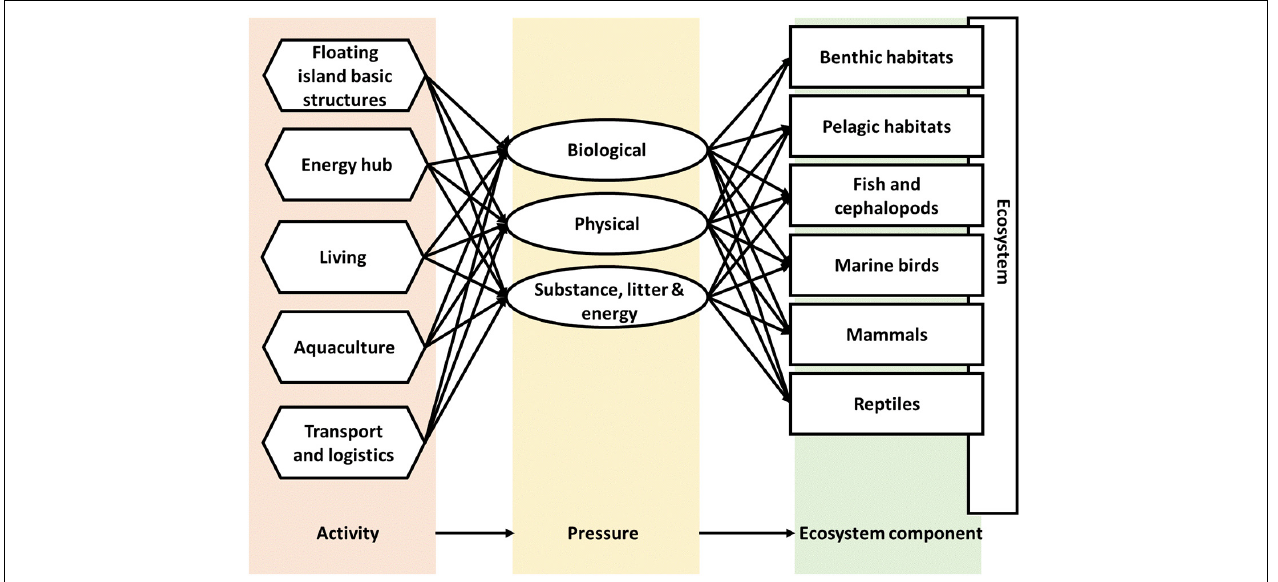
FIGURE 1 | Framework for floating island applications showing relationships between activities (left), pressures (middle), and ecosystem components (right). Note that pressure are aggregated and presented by MSFD pressure theme (European Commission, 2017b).